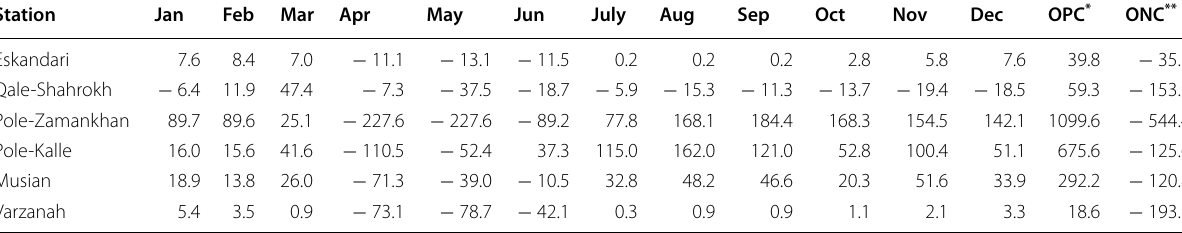
*Overall positive changes; ** overall negative changes